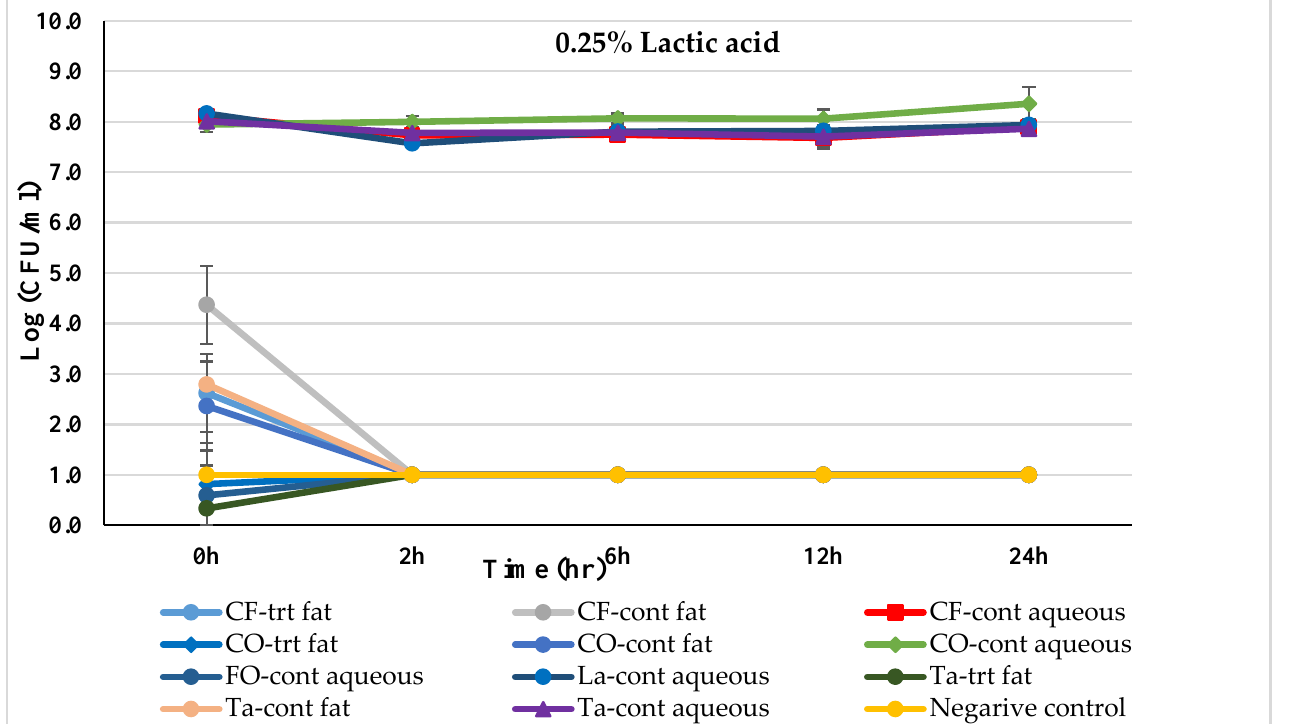
Figure 3. Mean logarithmic counts (log CFU/mL) of Salmonella spp. in different fat and oil systems with and without the inclusion of 0.25% lactic acid, evaluated separately for the aqueous phase and fat phase at 45 °C. Treatments from each phase were plated on TSA at different times. SBS, sodium bisulfate; CF, chicken fat; CO, canola oil; FO, fish oil; La, Lard; Ta, Tallow; Cont., control. Negative control consisted of fat-oil system without acidulant and Salmonella inoculation. The limit of detection is 1 log CFU/mL for this study. Because the three replications were averaged, for some of the treatments, the counts on 0 h appeared to be lower-than-detection limit. Error bars are ± 1 standard error of the mean.